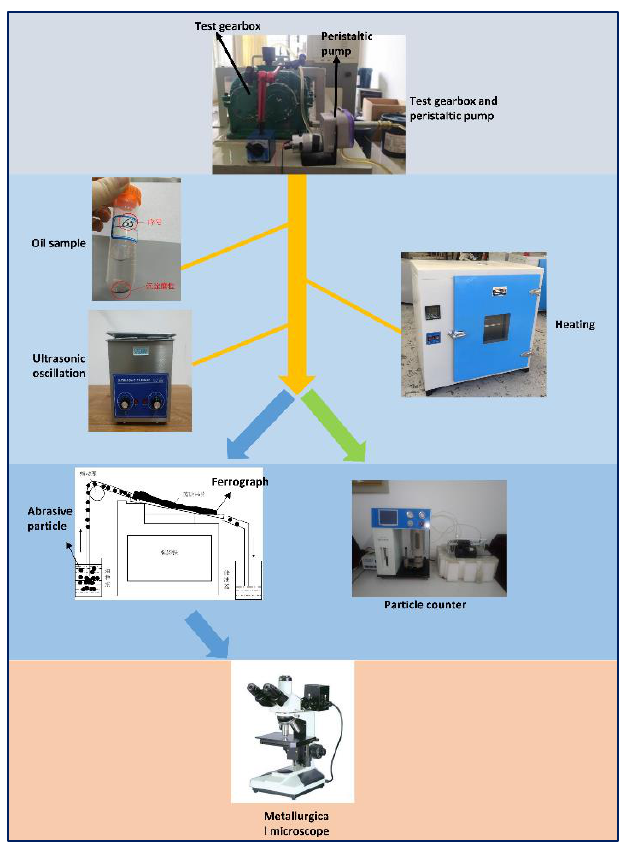
Figure 4. Flow chart of oil sample collection and preparation. Table 2. Instrument Specifications and Manufacturers.